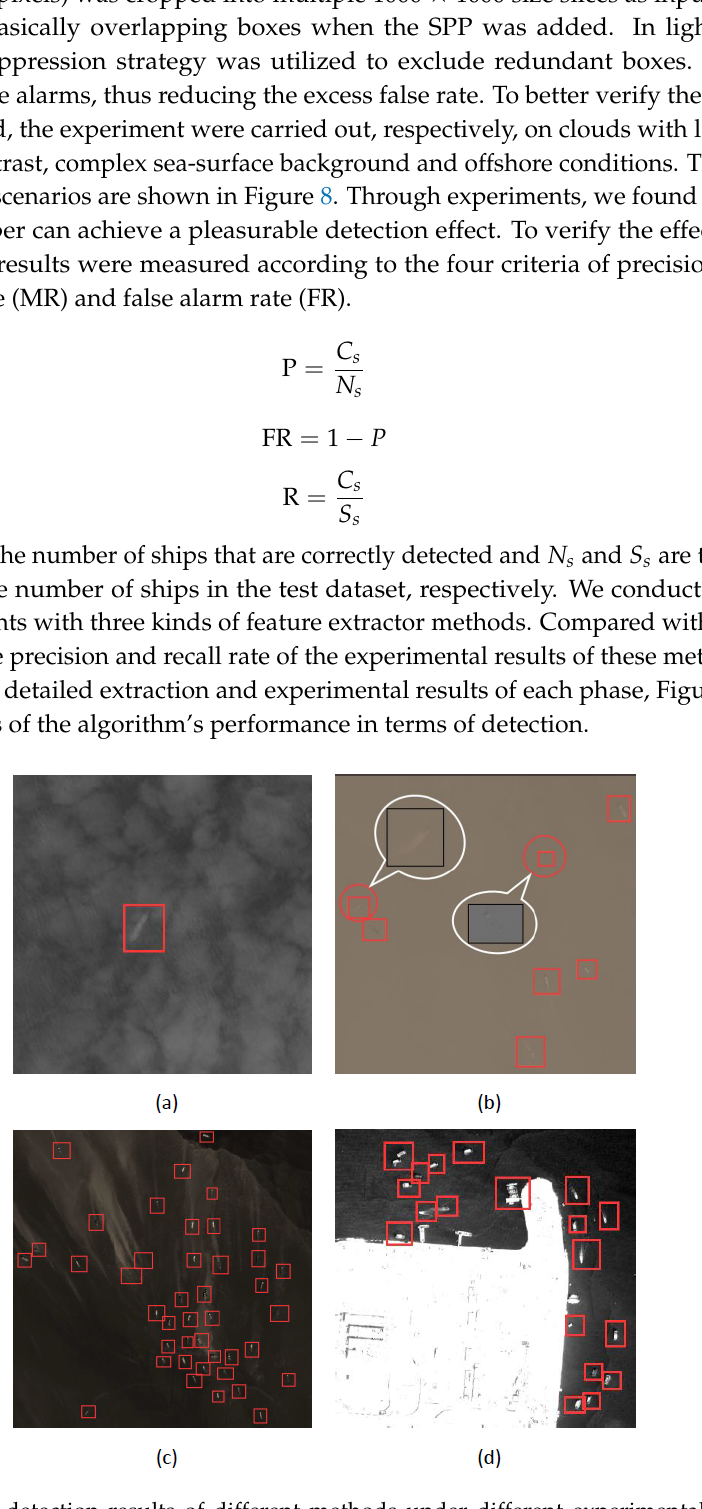
Figure 8. Target detection results of different methods under different experimental conditions: ( a ) cloud interference; ( b ) ship with low contrast; ( c ) complex sea conditions; and ( d ) near-shore